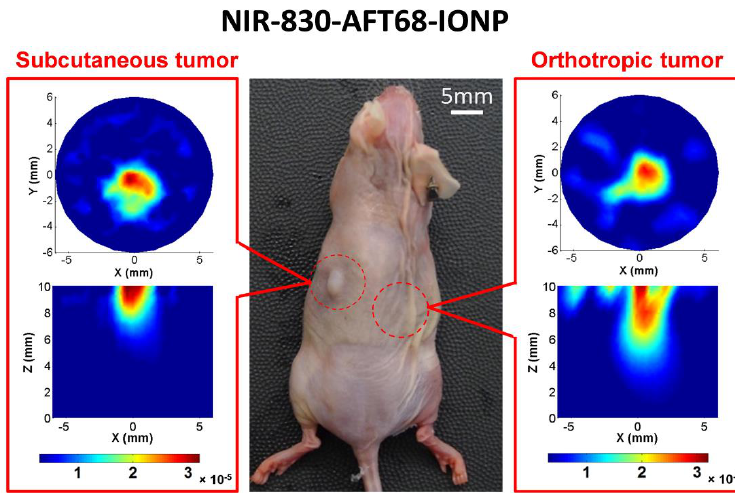
Figure 4. FMT images of a tumor-bearing mouse using NIR-830-ATF68-IONP: photograph of the mouse (middle), transverse and sagittal FMT slices of subcutaneous tumor (left), transverse and sagittal FMT slices of orthotropic tumor